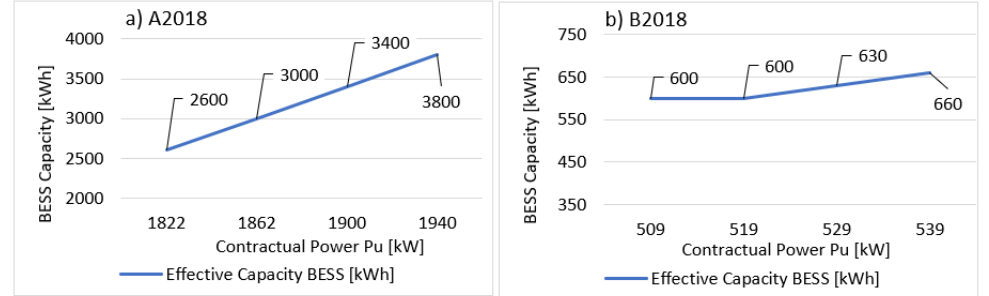
Figure 8. Effective BESS capacity with different contractual powers Pu [kW] for enterprises ( a ) A2018; ( b )